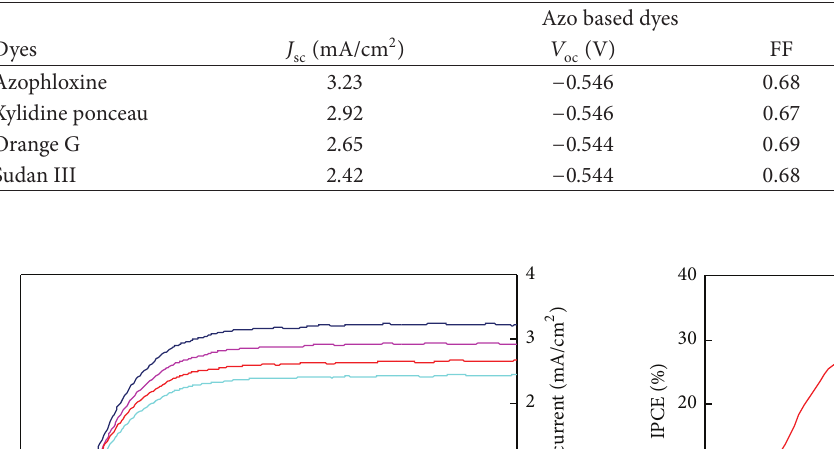
Table 4: DSSC performance parameters of azo based dyes.